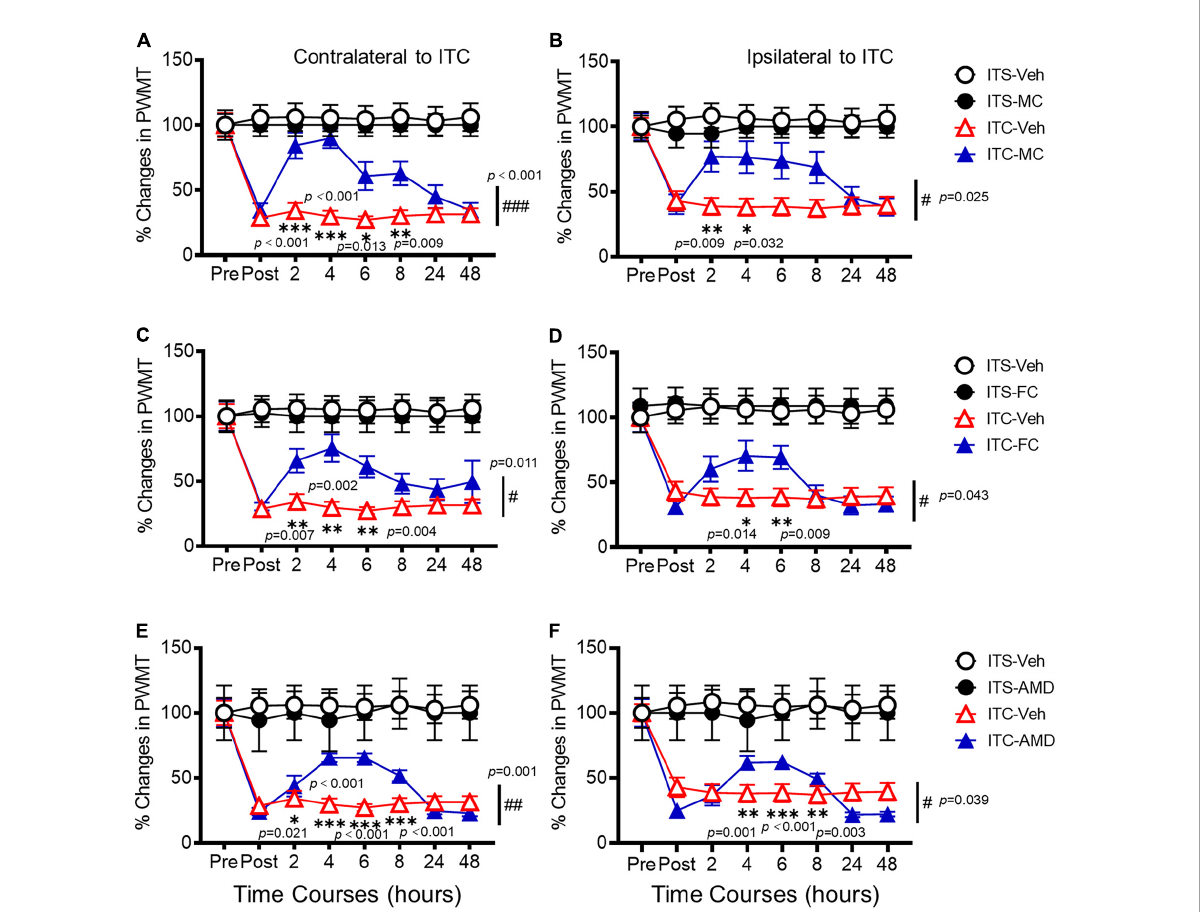
FIGURE8 Analgesic effects of i.t. antineuroinflammation treatment on thalamic hemorrhagic stroke pain hypersensitivity. Time courses of the analgesic effects following i.t. administration of MC (A,B) , FC (C,D) , and AMD3100 (AMD) (E,F) on the THS mechanical pain hypersensitivity 10 days after ITS or ITC (3 days after i.t. catheterization). Pre, the day before ITS or ITC; Post 2, 4, 6, 8, 24, and 48 h, time after i.t. treatment of vehicle or drug on day 10 after ITS or ITC (or day 3 after i.t. catheterization). Abbreviations see Figure 7 . n = 12 rats for ITS-Veh, ITC-Veh; n = 5 rats for ITS-MC; n = 11 rats for ITC-MC; n = 6 rats for ITS-FC; n = 10 rats for ITC-FC; n = 5 rats for ITS-AMD; n = 10 rats for ITC-AMD. * p < 0.05, ** p < 0.01,; # p < 0.05, ## p < 0.01, ### p < 0.001, ITC-MC/ITC-FC/ITC-AMD vs.